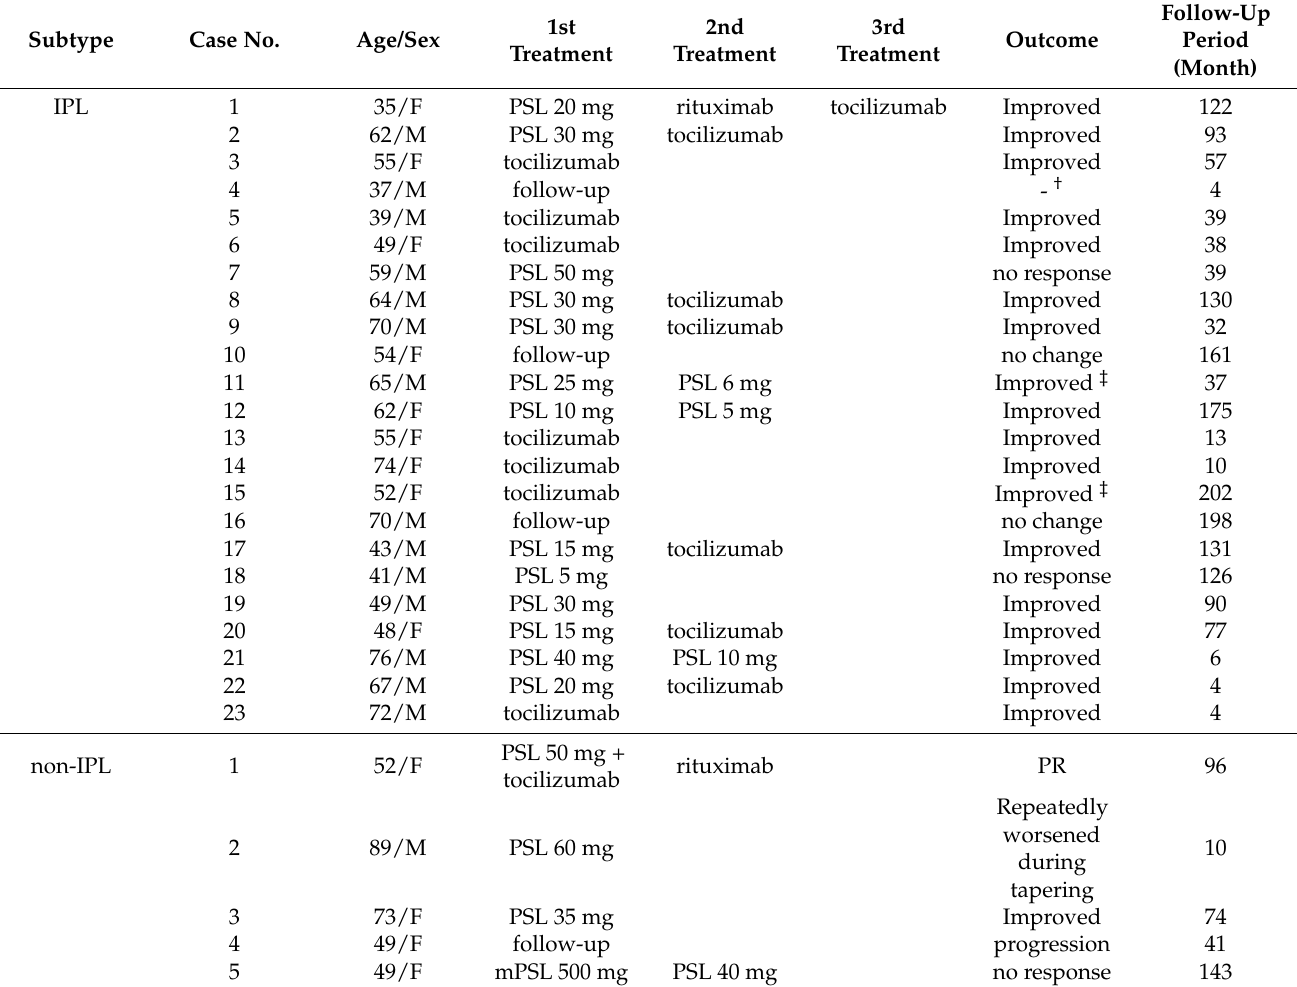
Table 3. Treatment and clinical courses of